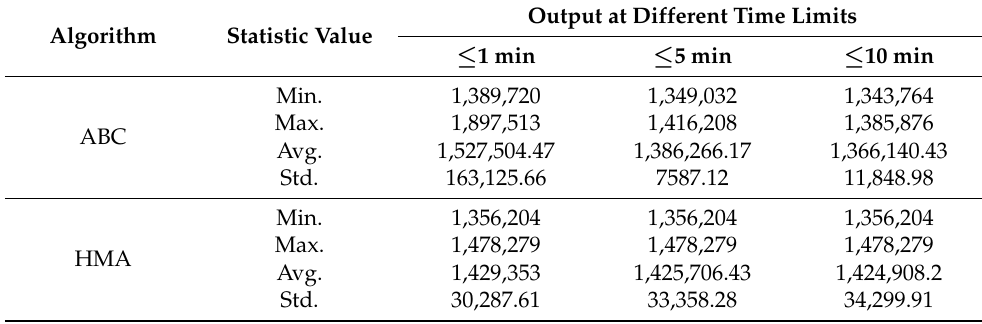
Table 6. Statistics of the total cost of the globally best solution of the HMA and the ABC algorithms on the “egl-g2-A” instance, within different time